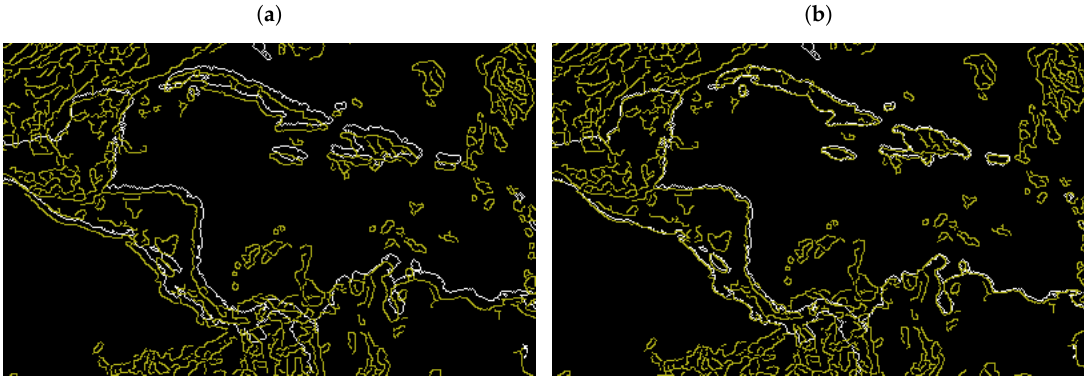
Figure 6. Comparison of the theoretical coastline (white lines) and the radiometric coastline (yellow lines) for one of the regions shown in Figure 1 ( a ) before and ( b ) after applying the